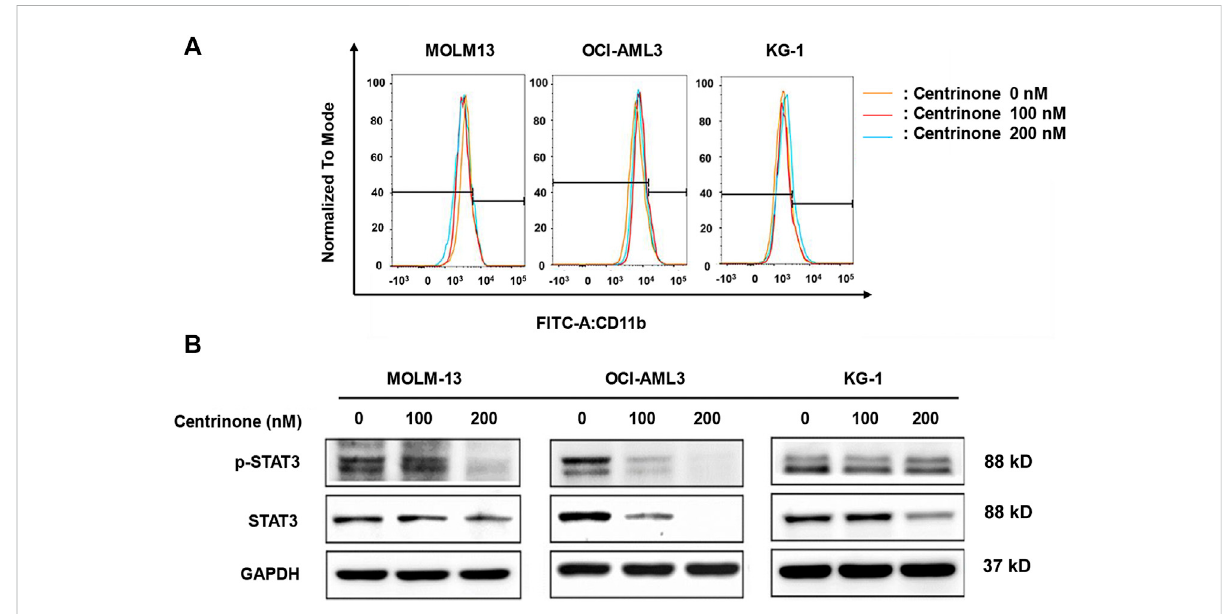
FIGURE 6 Effects of Centrinone on the expression of CD11b and the activation of STAT3 in AML cell lines. (A) Effects of Centrinone on the expression of myeloid cell differentiation marker CD11b in AML cell lines. AML cells were treated with Centrinone for 48 h, and the expression of CD11b was analyzed by fl ow cytometry. (B) Centrinoneinhibited the activation ofSTAT3. AML cells treated with differentconcentrations of Centrinone for 72 h, and then the expression of STAT3 and p-STAT3 were detected by Western blot. The expression of GAPDH was used as an internal